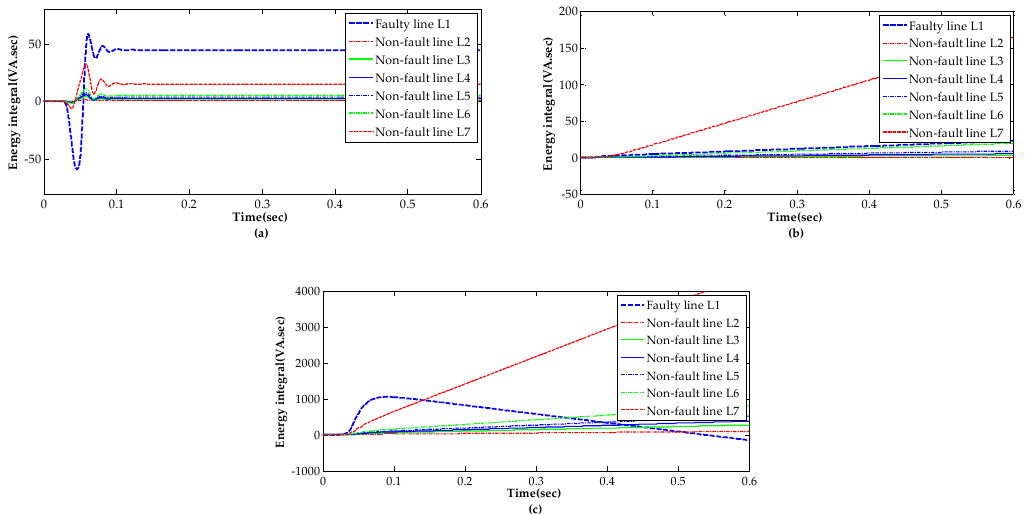
Figure 13. Comparison of the three energy integral schemes under a metal SPG fault occurring on the line L 1 , at 2 km away from the bus, at 0° initial phase angle. ( a ) The results of the energy integral scheme in this paper; ( b ) the results of the energy integral scheme in [20]; ( c ) the results of the energy integral scheme in [21].